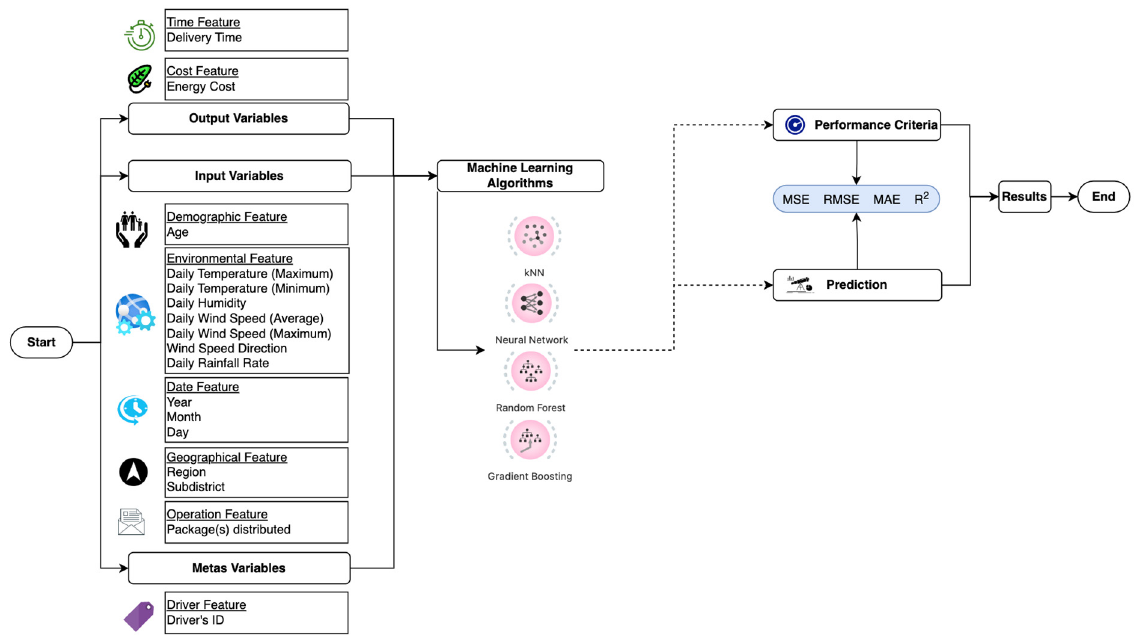
Figure 3. The flow chart of the ML methodology .